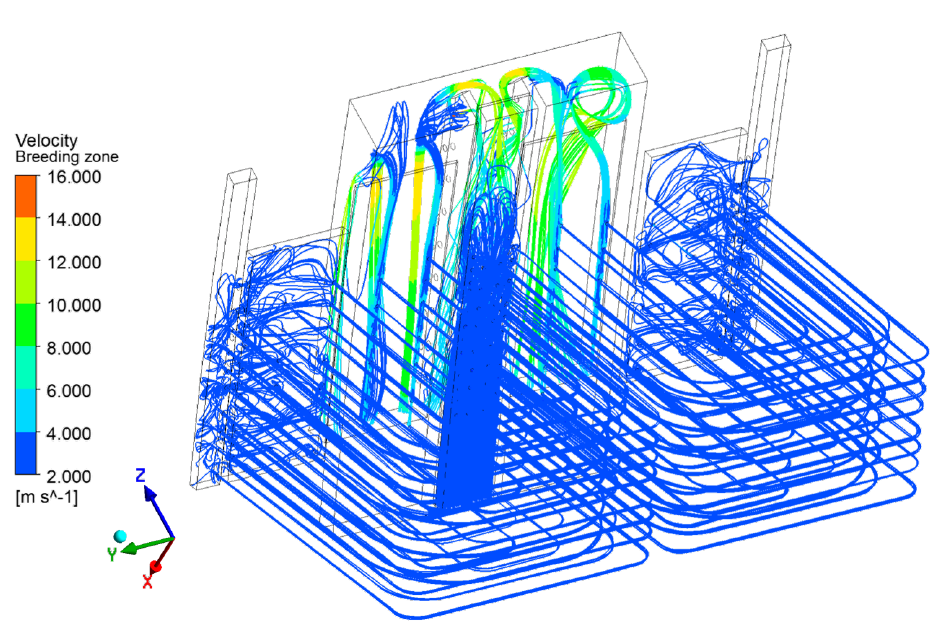
Figure 10. Fluid velocity in the BZ cooling water.